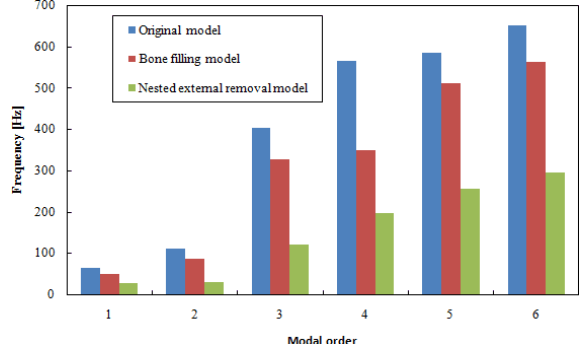
Figure 20. Modal comparison between the two optimized models and the original model.